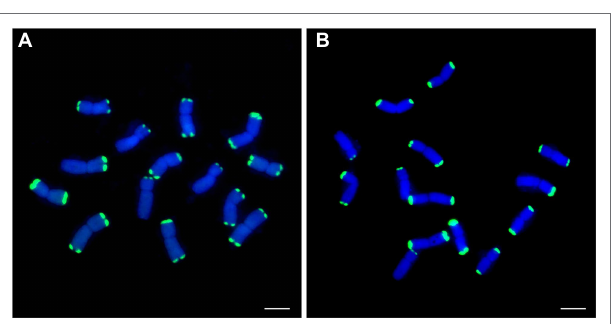
FIGURE 8 | FISH patterns of repetitive DNA probes in P. huashancia . (A) pPh15 (green), (B) pPh37 (green). Scale bar: 10 μ